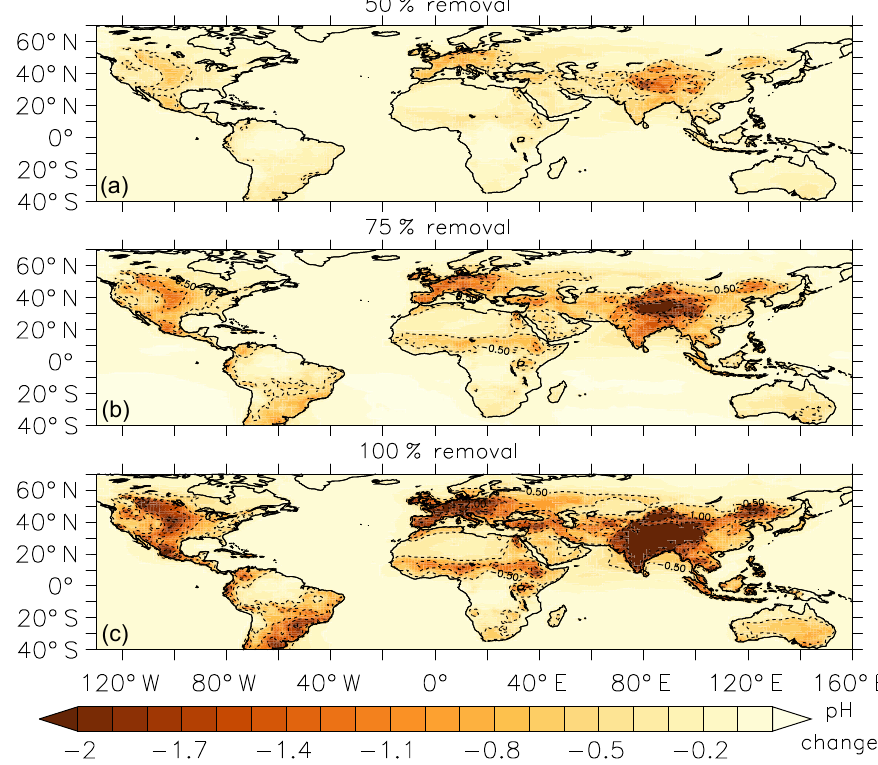
Figure 6. Absolute annual average surface aerosol pH changes (all modes) from three scenarios with agricultural emission reductions of 50, 75 and 100% ( a , b and c ,